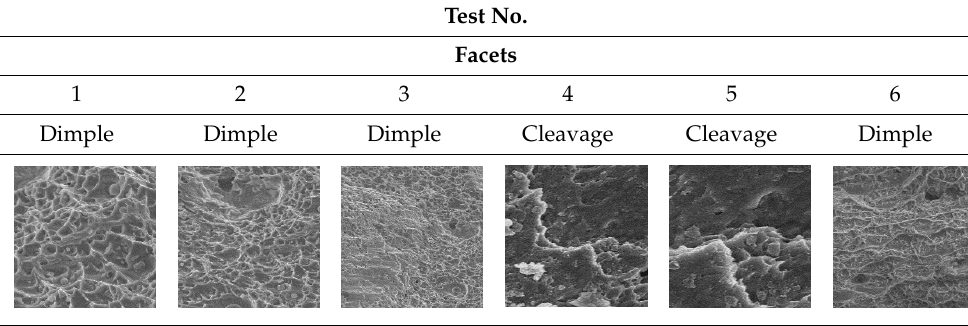
Table 7. Results of fracture geometry analysis of the heat-affected zone according to the Charpy impact test. Test No.